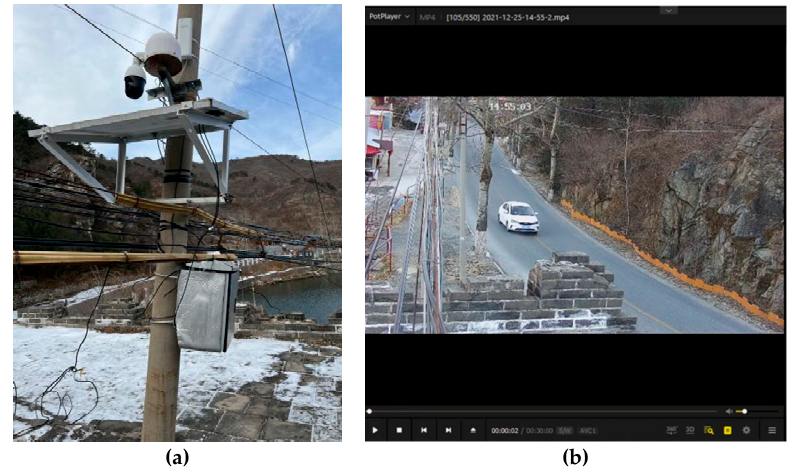
Figure 3. The video camera monitor and video images: ( a ) the video camera monitor; and ( b ) the video images.